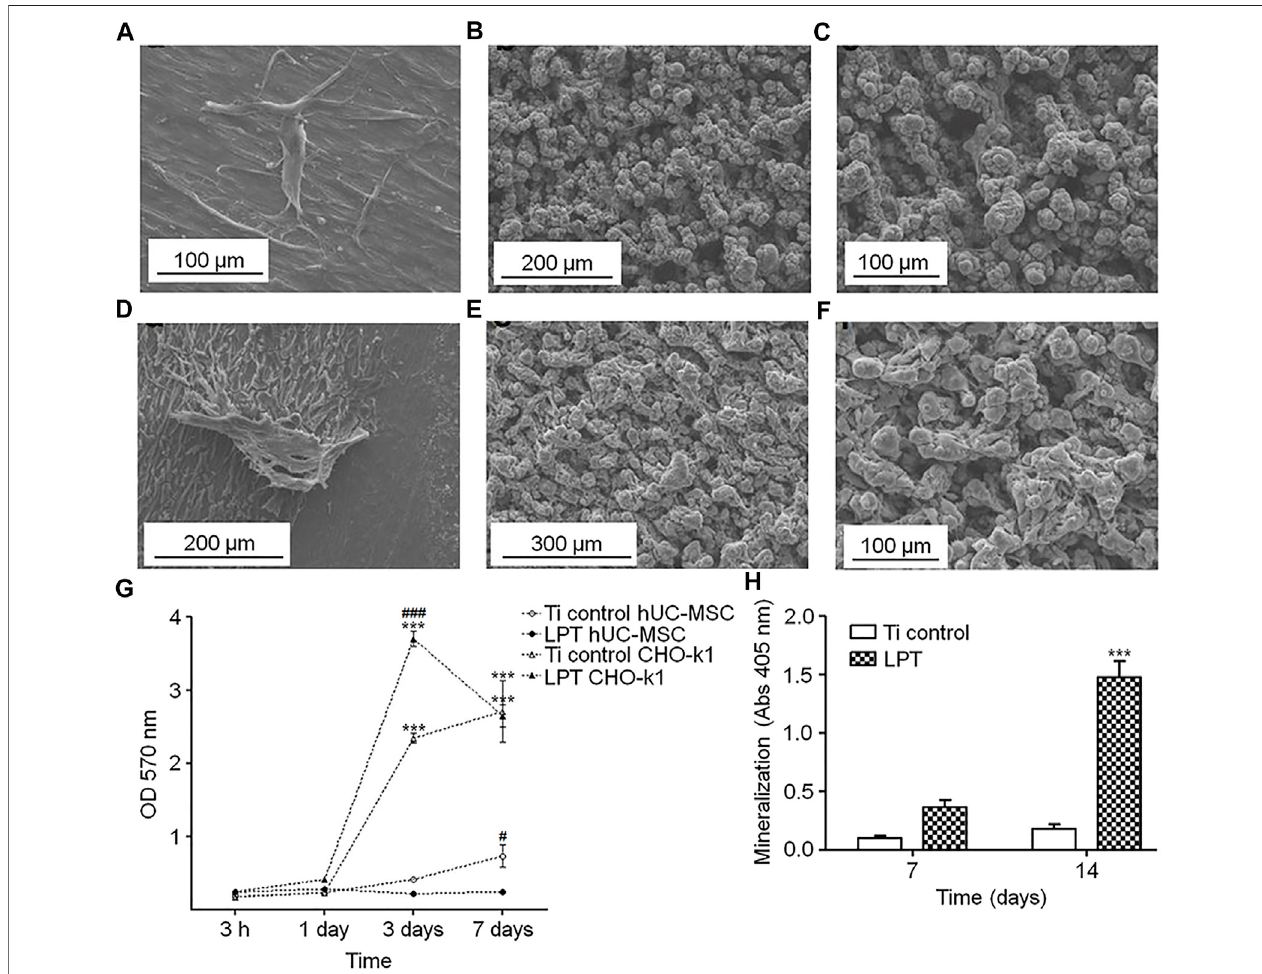
FIGURE 5 | (A – F) hUC-MSCs on Ti control (A) and laser-processed titanium (B,C) surfaces. CHO-k1 cells on Ti control (D) and LPT (E,F) surfaces. (G,H) Results of cell metabolic activity assay and calcium deposition assay. Reprinted with permission from (Bressel et al., 2017).